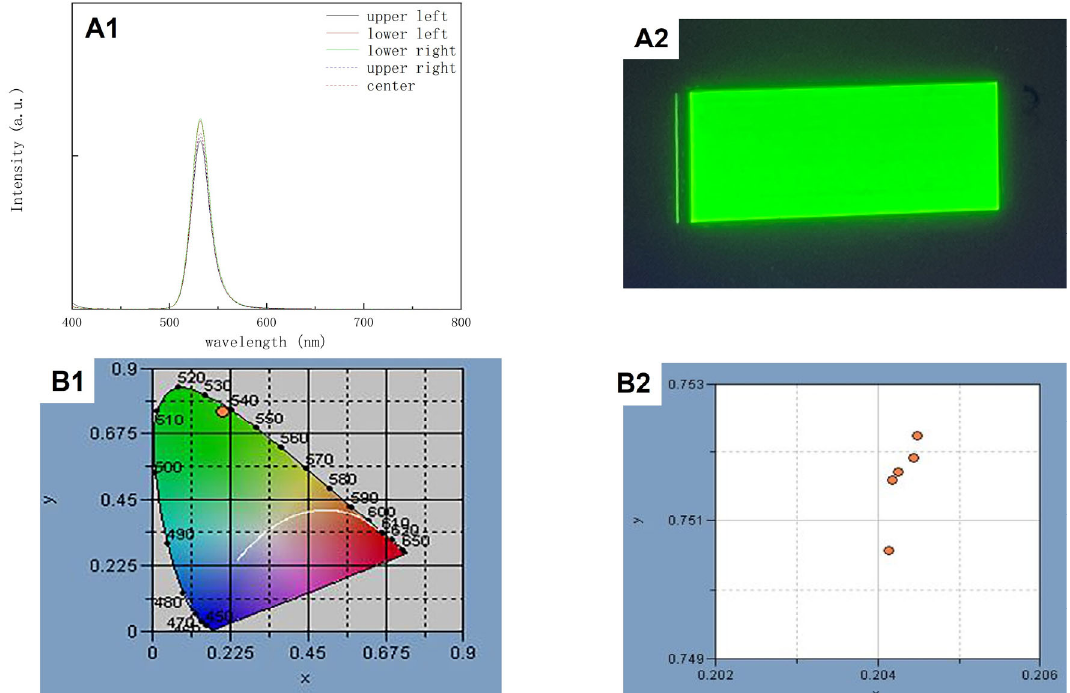
Figure 9. ( A1 ) The photoluminescence (PL) spectrum of the printed green QD ‐ PDMS film at different positions. ( A2 ) Microscope image of the printed green QD ‐ PDMS film under 365 nm UV excitation. ( B1 ) Color coordinate value of the printed green QD ‐ PDMS film. ( B2 ) Enlarged color coordinate value of the printed green QD ‐ PDMS film at different positions.